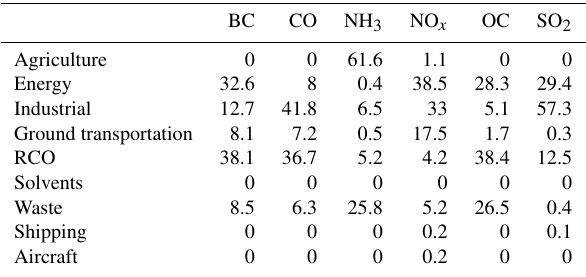
Table 3. The 2014 anthropogenic emission estimates by sector Table 4. Bottom-up biomass Global Fire Assimilation System (in %) over China, excluding biomass burning, from the Commu- (Kaiser et al., 2012) burning CO emission estimates from the up- nity Emissions Data System (CEDS) for a representative set of per Mekong region (17 to 24 ◦ N, 95 to 105 ◦ E) and AIRS CO over constituents: black carbon (BC), carbon monoxide (CO), ammo- southern China from 23 January to 8 April, for nia (NH 3 ), nitrogen oxides (NO x ), organic carbon (OC), and sul- fur dioxide (SO 2 ). Residential, commercial, and other sectors are combined as RCO. BC CO